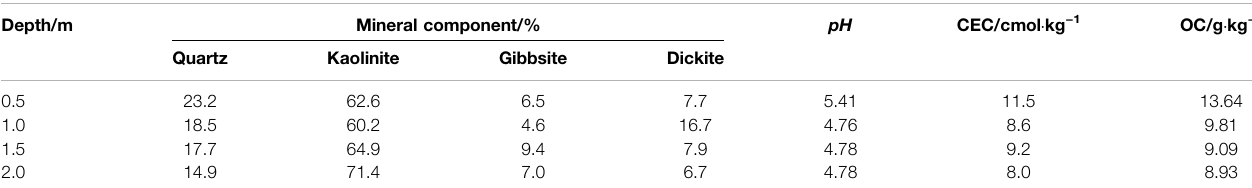
TABLE 2 | Mineral composition and physicochemical analysis table of residual soil.